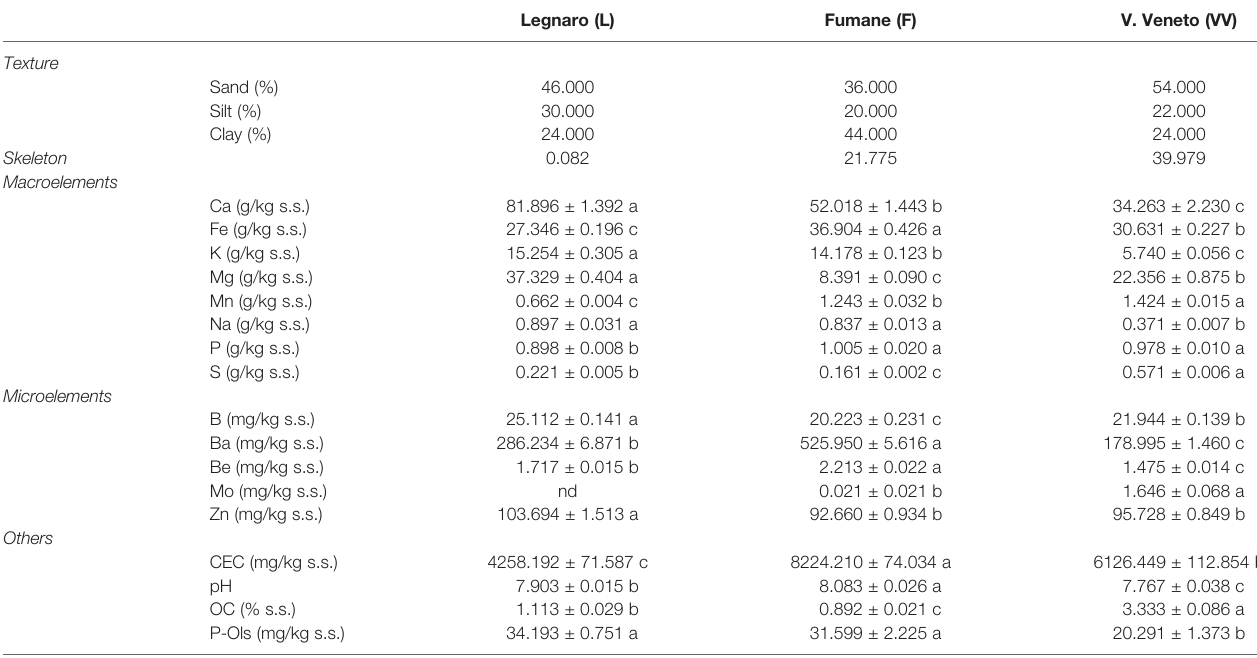
TABLE 1 | Main soil physico-chemical characteristics of VV, L, and F soils.